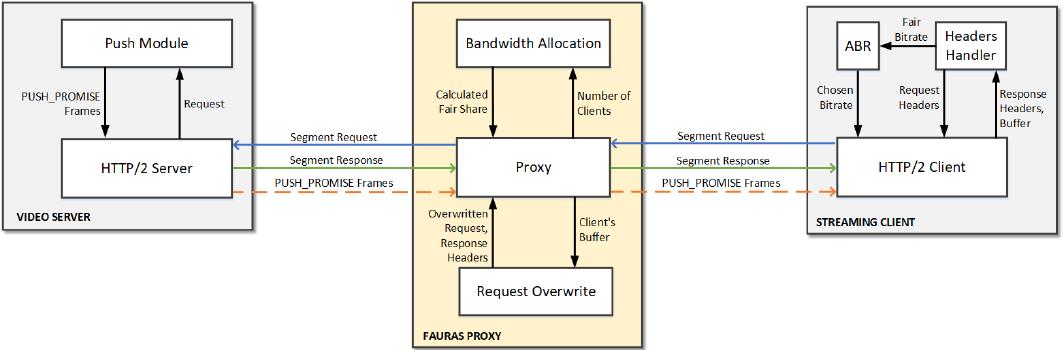
Figure 1. Block diagram of the FAURAS